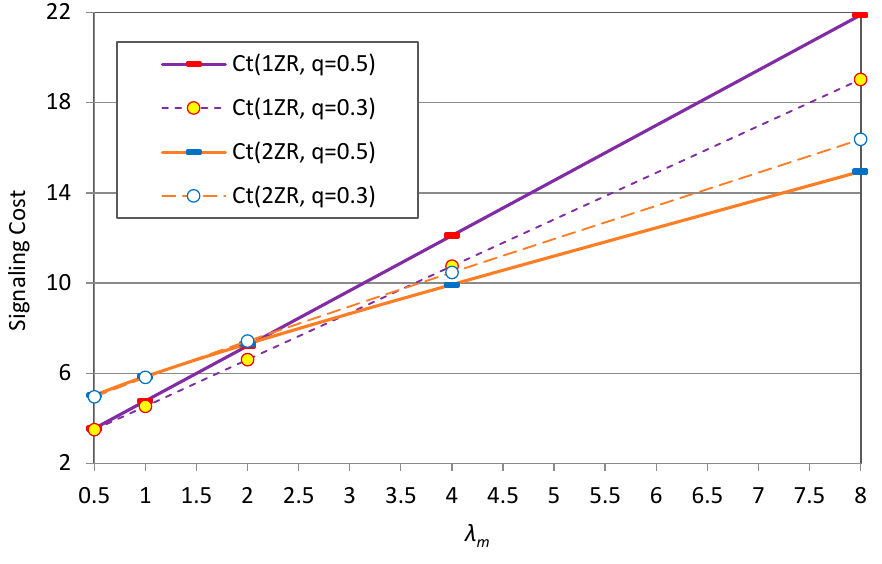
Figure 13. Total signaling cost for various q ( n = 4, λ c = 1).